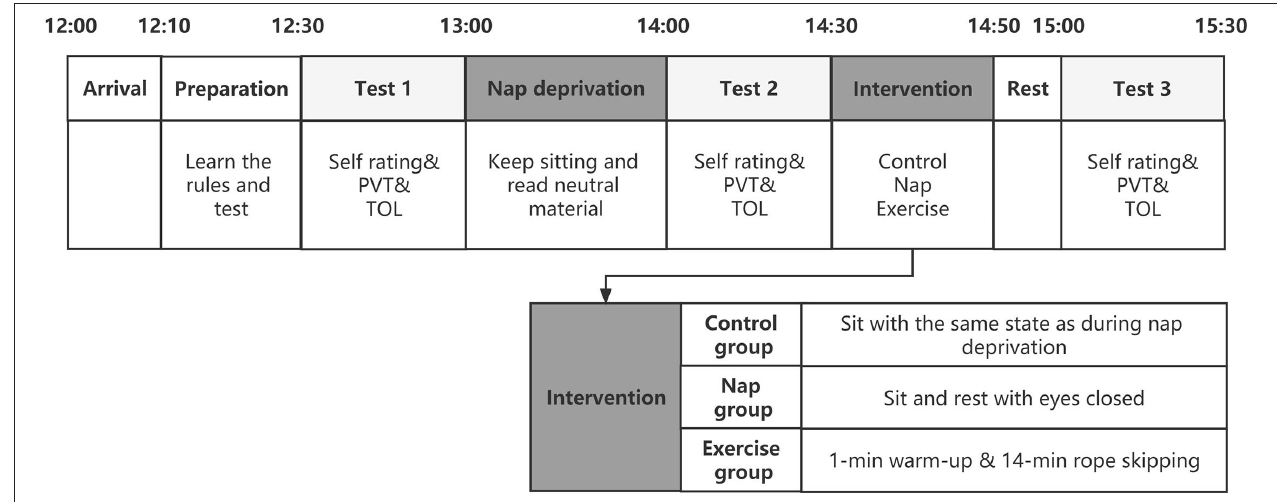
FIGURE 1 | A schematic representation of the overall study protocol. The three test points are filled with gray and the order of the tests is fixed. The intervention section was expanded to represent the interventions in the three groups. Self-rating includes subjective alertness, fatigue and mood. TOL, The Tower of London Task; PVT, Psychomotor Vigilance